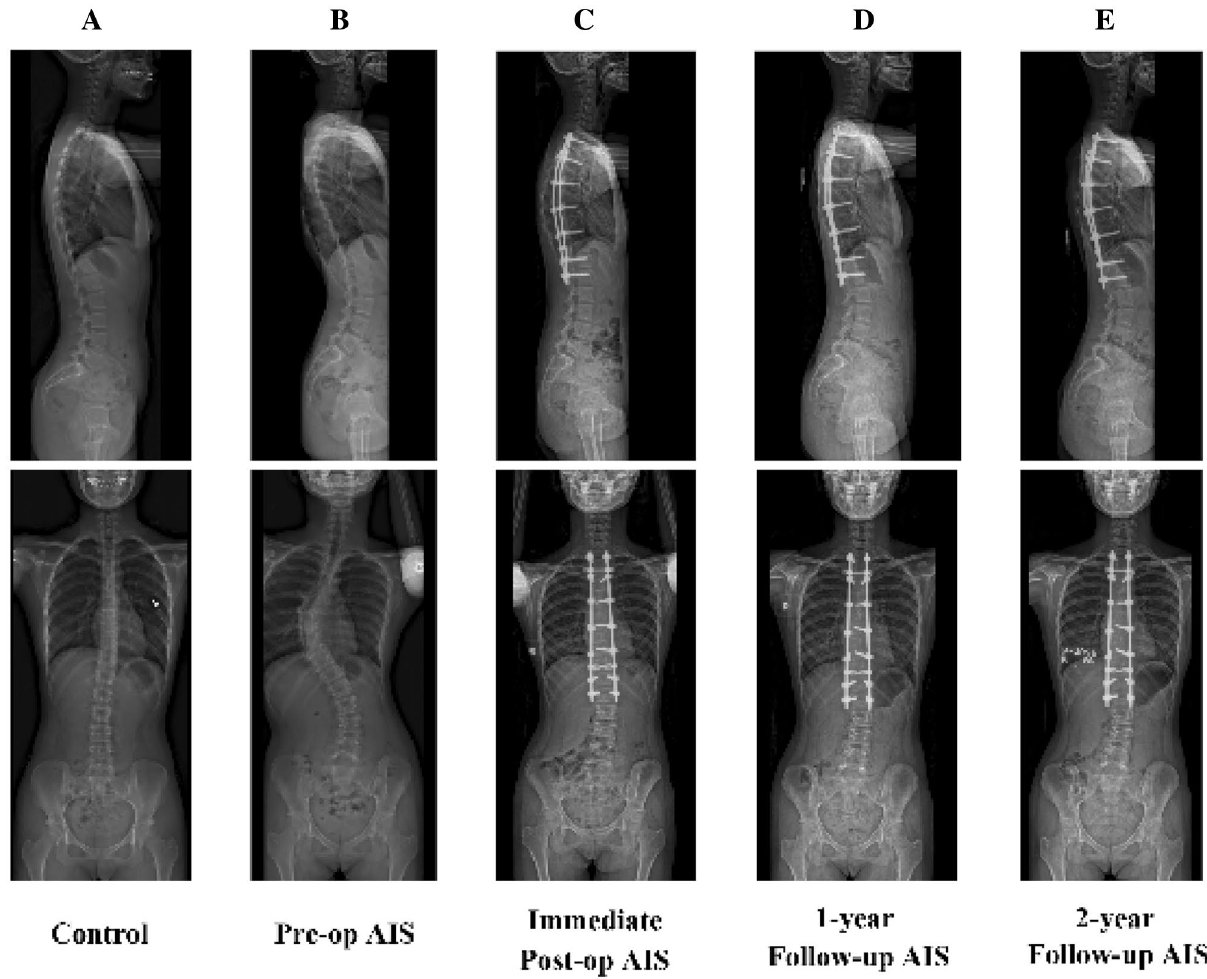
Figure 4. Sagittal radiographs of an asymptomatic female control ( A ) and a female patient with adolescent idiopathic scoliosis taken pre-operatively ( B ), and immediate post-operatively ( C ), at 1-year ( D ) and 2-year ( E )